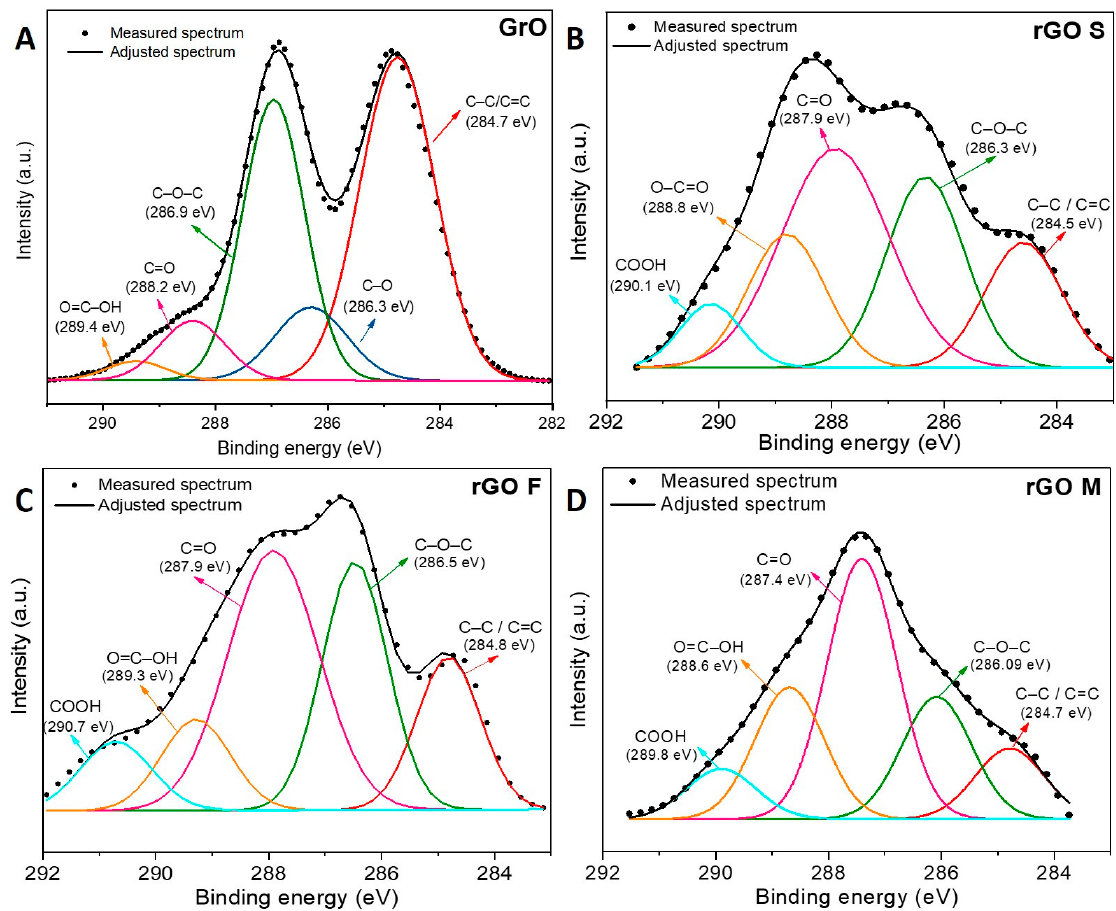
Figure 2. High-resolution X-ray photoelectron spectra (XPS) spectra of ( A ) graphite (GrO), ( B ) rGO S, ( C ) rGO F, and ( D ) rGO M. Table 1. Functional groups and percentages obtained by X-ray photoelectron spectra (XPS) of graphite (GrO) and nano- hybrids rGO S, rGO F, and rGO M.